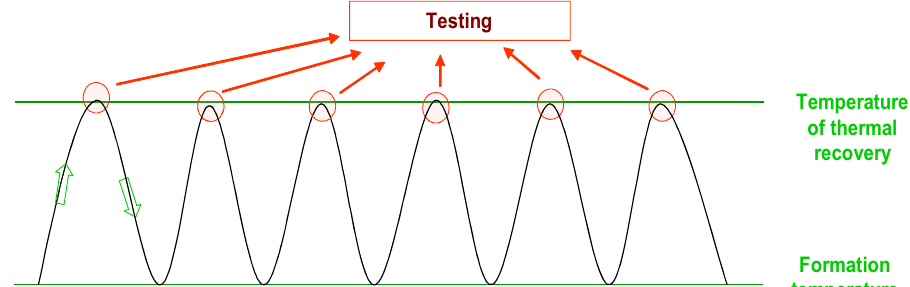
Fig. 3 Sketch map of test procedures of compression coefficient under the high- temperature cycle